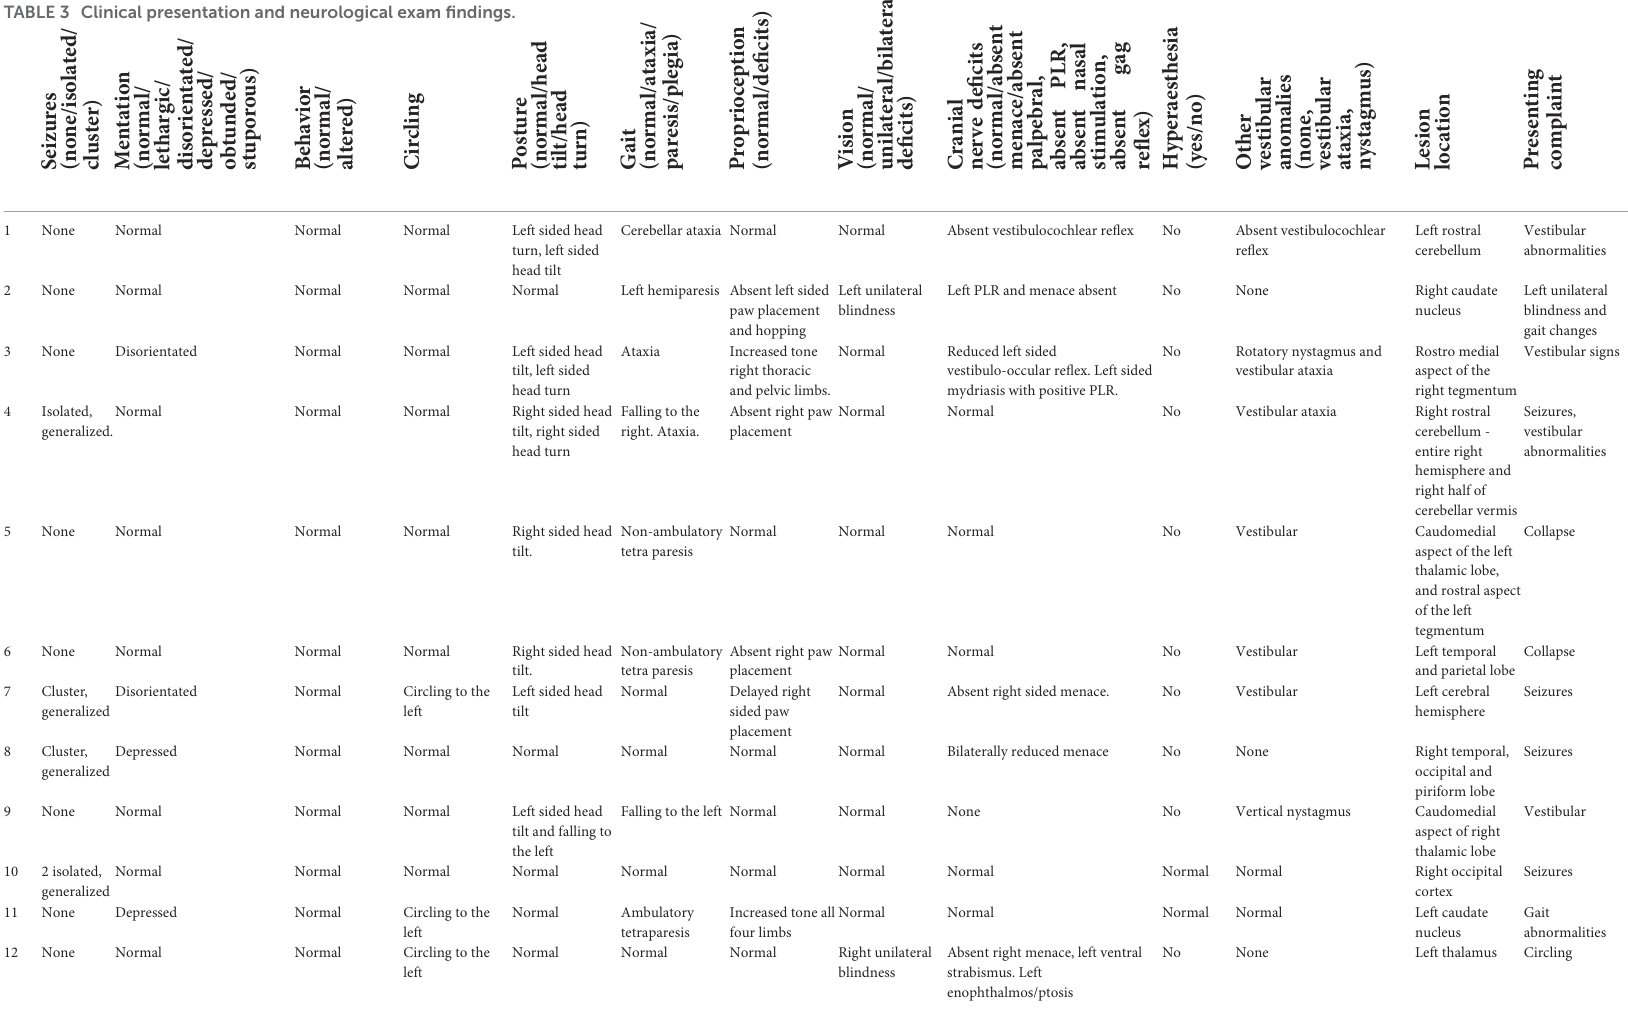
TABLE 3 Clinical presentation and neurological exam